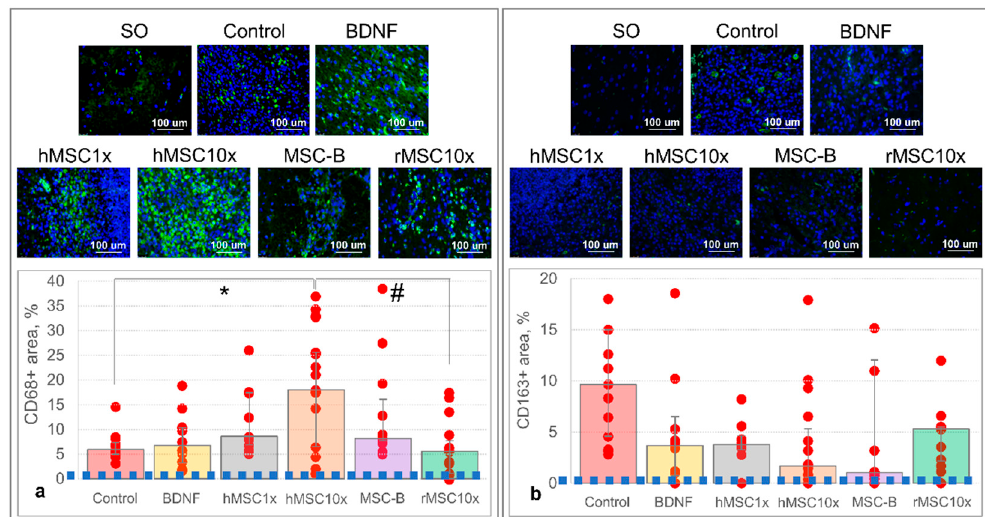
Figure 5. The results of the immunohistochemical staining of brain slices at day 14 after the intracerebral hemorrhage: ( a ) immunostaining for CD68; ( b ) immunostaining for CD163. On the photos: the green staining corresponds to the CD68 or CD163 staining; the blue staining corresponds to cell nuclei. On the diagram: the blue dashed line equals the area of the brain lesion site in the SO animals. Data is presented as a median (25%; 75%). [*—H (4,40) = 10.404, p = 0.034, n ≥ 9, ANOVA on ranks; #—H (5,48) = 16.689, p = 0.005, n ≥ 9, ANOVA on ranks].